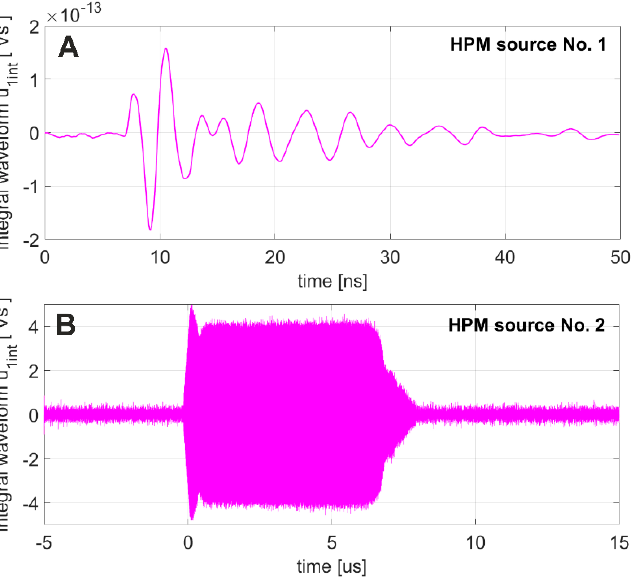
Figure 8. Waveforms of signal integrals from Figure 4 after the application of high-pass filtration: ( A ) Marx generator; ( B ) magnetron generator.